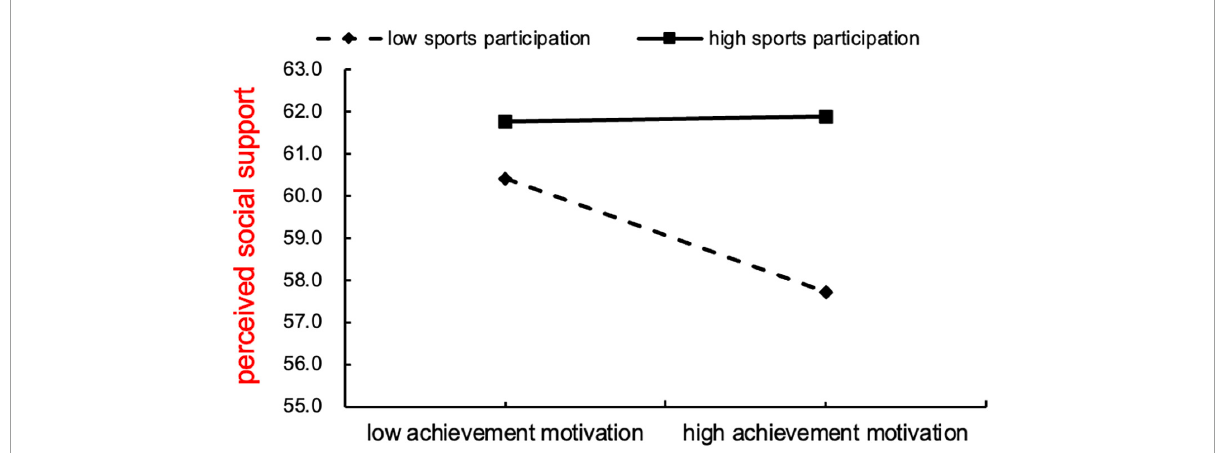
FIGURE2 The moderating effect of sports participation on achievement motivation and perceived social participation.